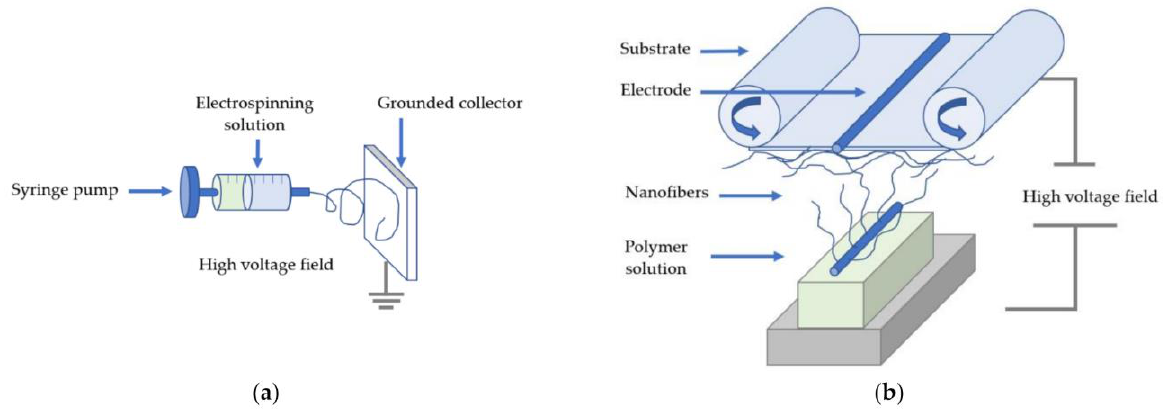
Figure 2. Needle-based ( a ) and needle-free ( b ) electrospinning setups. Reprinted from [30], originally published under a CC-BY 4.0 license.